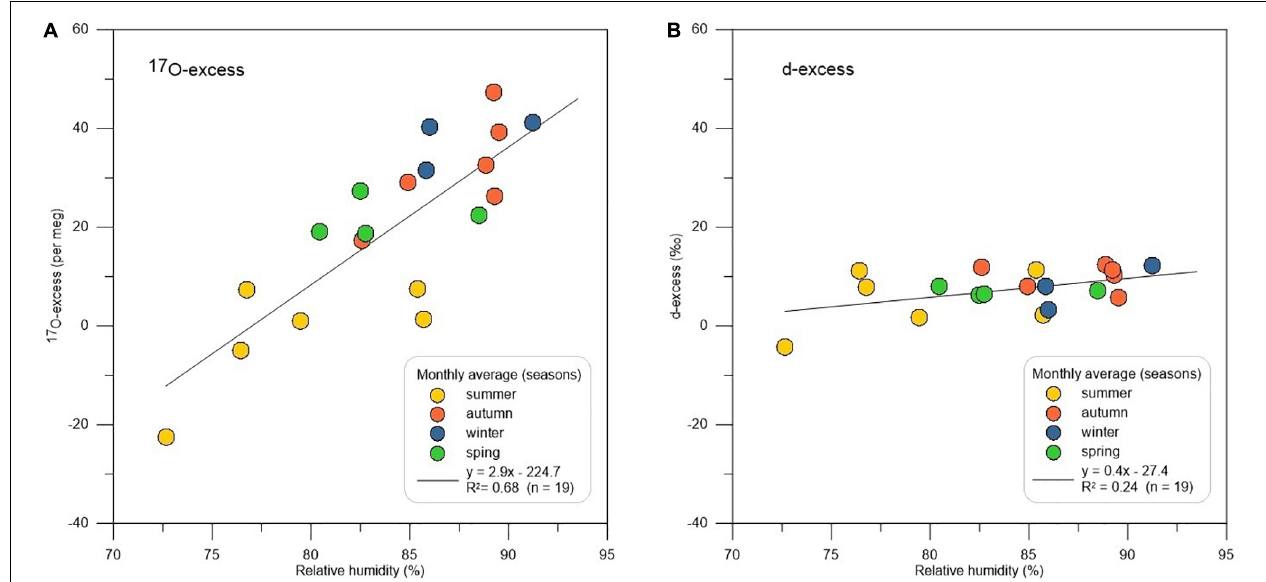
FIGURE 7 | (A) Monthly 17 O-excess precipitation variation versus RH at the sampling site. (B) Monthly d-excess precipitation variation versus RH at the sampling